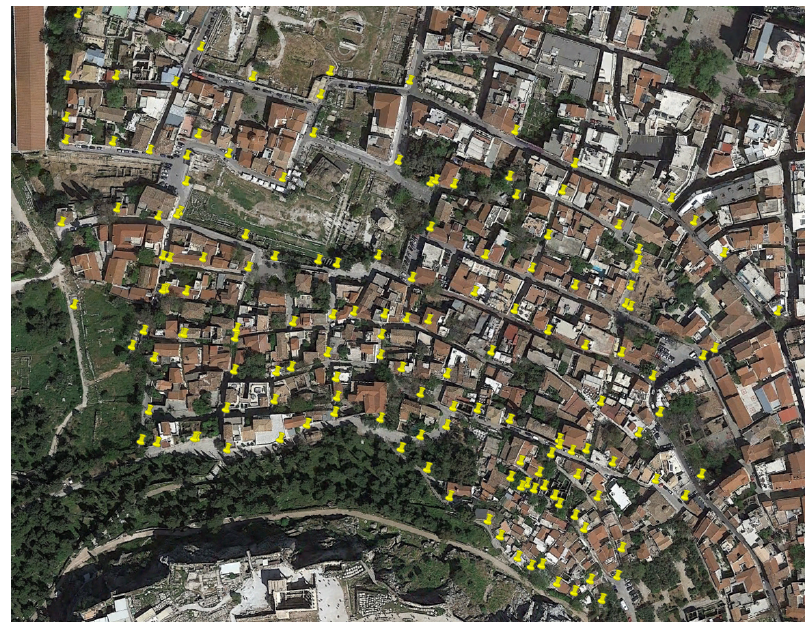
Figure 15: Control points over satellite